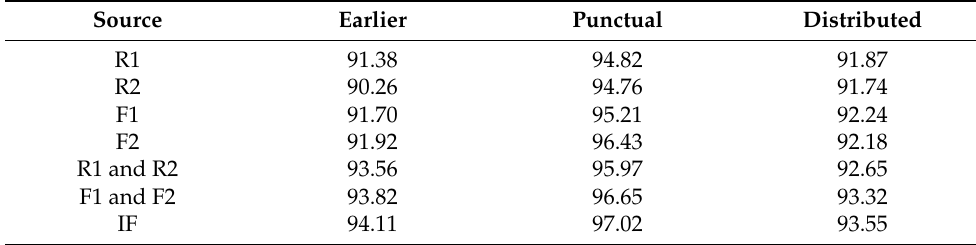
Table 3. Average accuracy of supervised